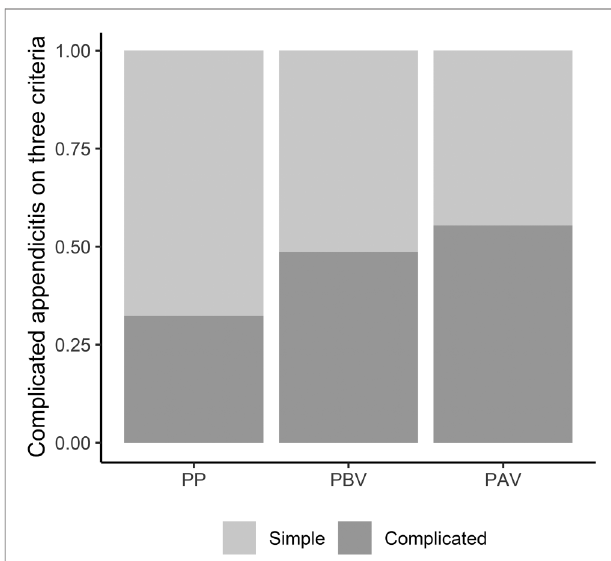
FIGURE 4 | Theproportionofcomplicatedappendicitisonthreecriteria.PP,pre- pandemic; PBV, pandemic (before vaccination);PAV, pandemic (after